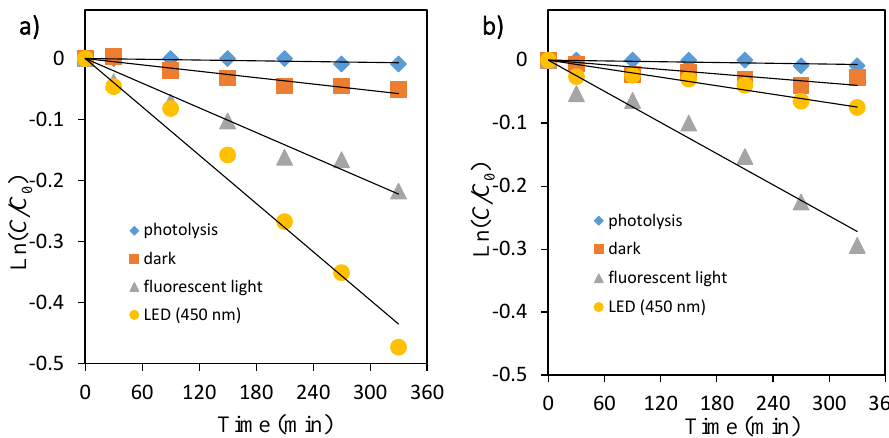
Figure 6. Kinetic plot of Ln( C/C 0 ) versus irradiation time for the photocatalytic degradation of methyl orange. ( a ) TiO 2 , ( b ) ZnO.